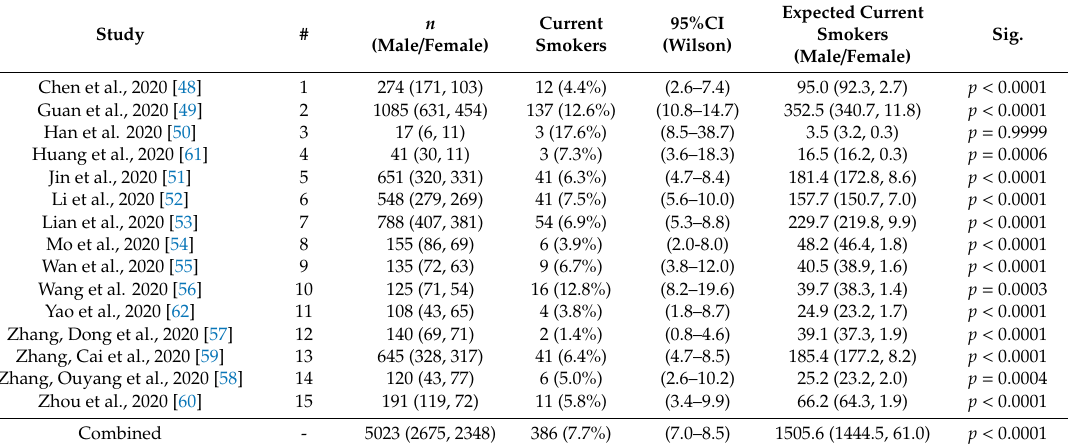
Table 1. Comparison of the hospitalised current smokers in the Chinese COVID-19 outbreak. Fifteen studies are described. The combined analysis is the result of adding the 15 individual studies. For each study, the number of male and female hospitalised patients, current smoker patients, 95%CI calculated with Wilson’s procedure, expected current smokers both pooled and by gender, and statistical significance (Sig.; p ) are shown. Expected current smokers were estimated using 54% and 2.6% for males and females, respectively [21]. A column with a consecutive numbering of the studies (#) is also included.